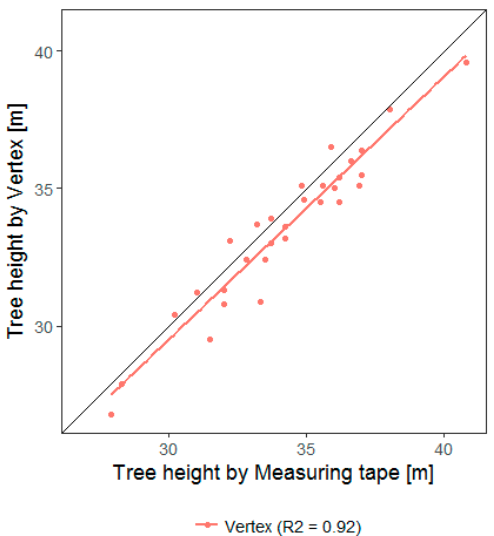
Figure 4. Regression analysis between tree height recorded using Vertex (indirect) and tree height recorded using a measuring tape (direct). The black line represents a 1:1 correlation between the two measurement techniques. Table 3. Overview of the statistical results of the remote sensing datasets and the measurements via Vertex. Tree heights recorded via measuring tape were assumed as the real tree